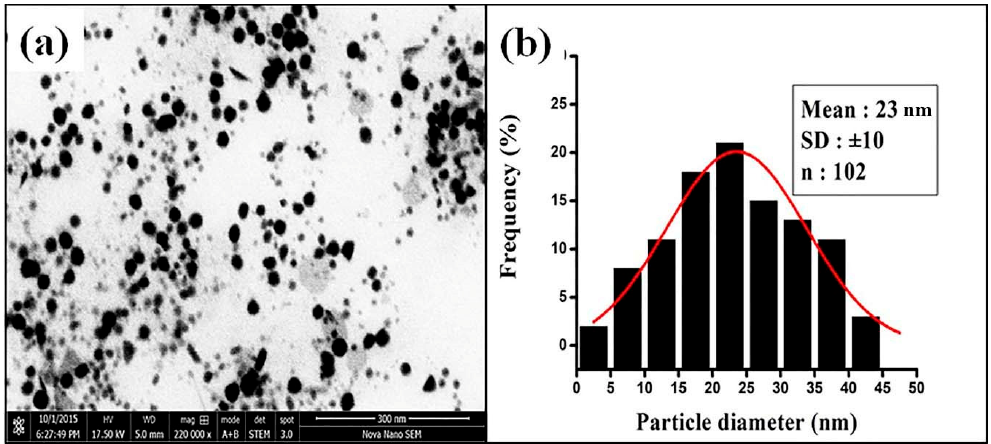
Figure 6. ( a ) Scanning transmission electron microscopy (STEM) image of FAuNPs and ( b ) particle size distribution of FAuNPs.